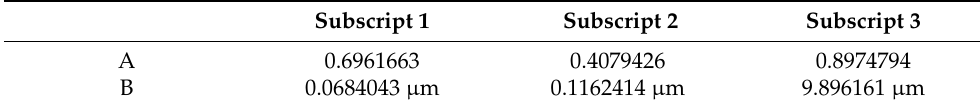
Table 1. Parameters for the Sellmeier equation of